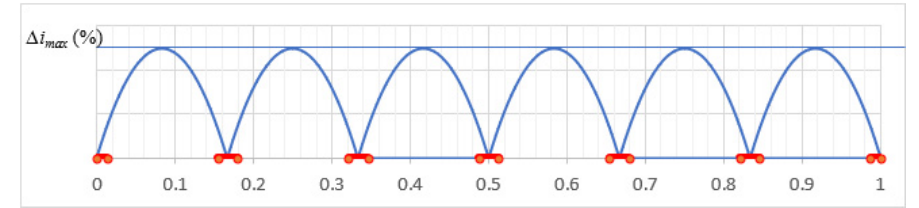
Figure 26. Six-phase DC–DC converter current ripples and usable duty cycle regions. One option for determining the permissible D ranges is to choose specific percentage values of ∆ I that are slightly higher than zero. Then, the maximum permissible pulsation points are marked on the ∆ I line both to the left and to the right of D 0 n ; then the corre- sponding D min and D max values can be found on the x-axis. However, the ranges of D to be used in further analysis are determined using Equations (17) and (18).